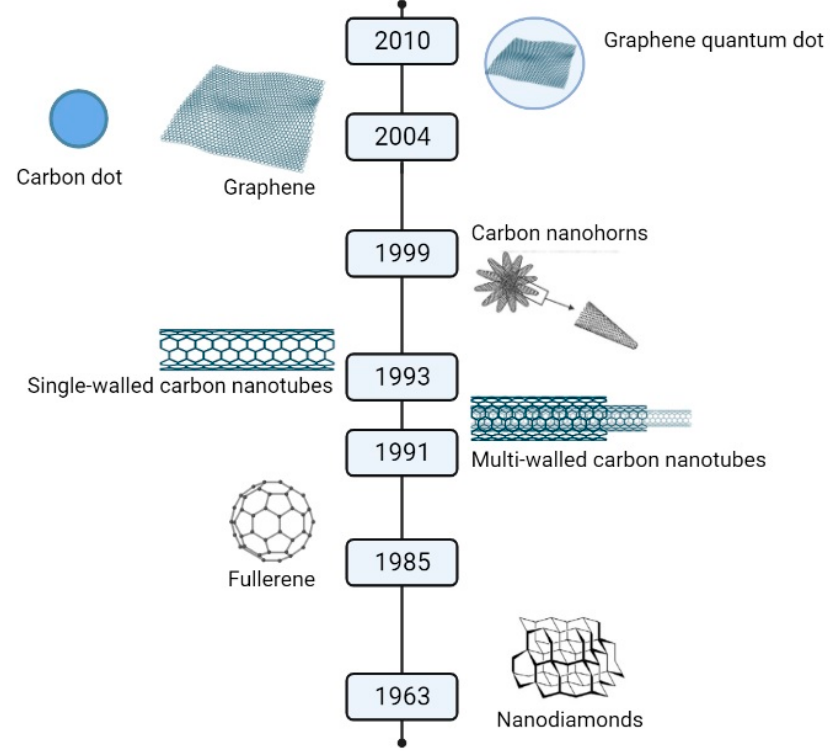
Figure 1. Timeline of discovered graphene.